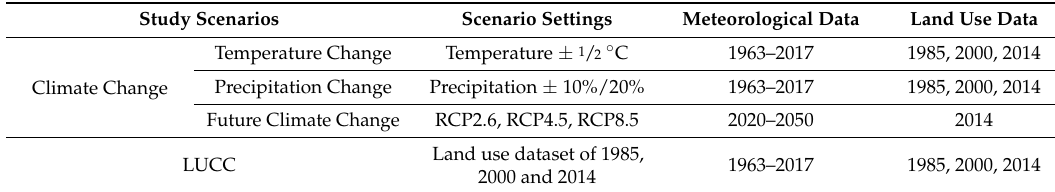
Table 2. Study scenarios.